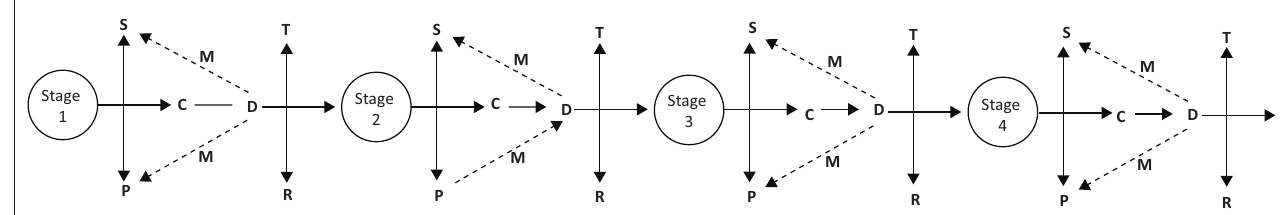
FIGURE 1: Provus’ Discrepancy Evaluation